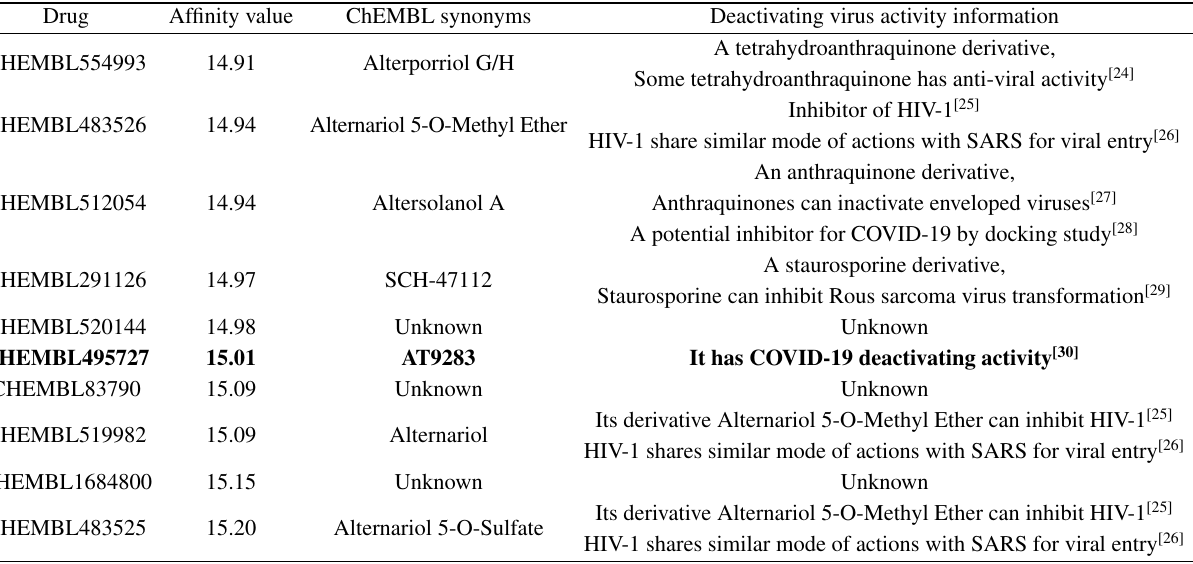
Table 6 Top 10 drugs with high affinity score to